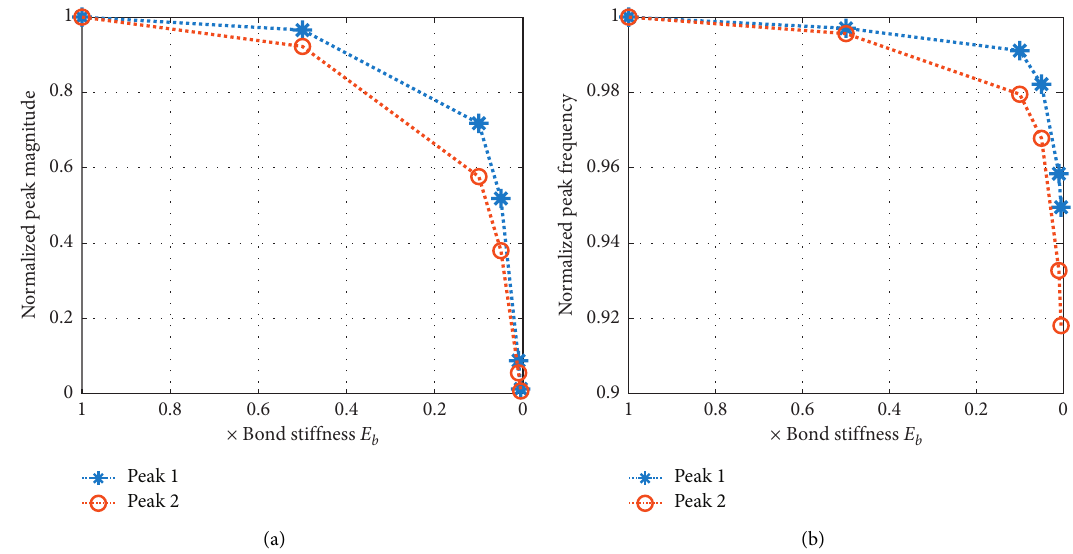
Figure 16: Shifts in resonant peaks caused by the shear lag effect. (a) Normalized magnitude. (b) Normalized